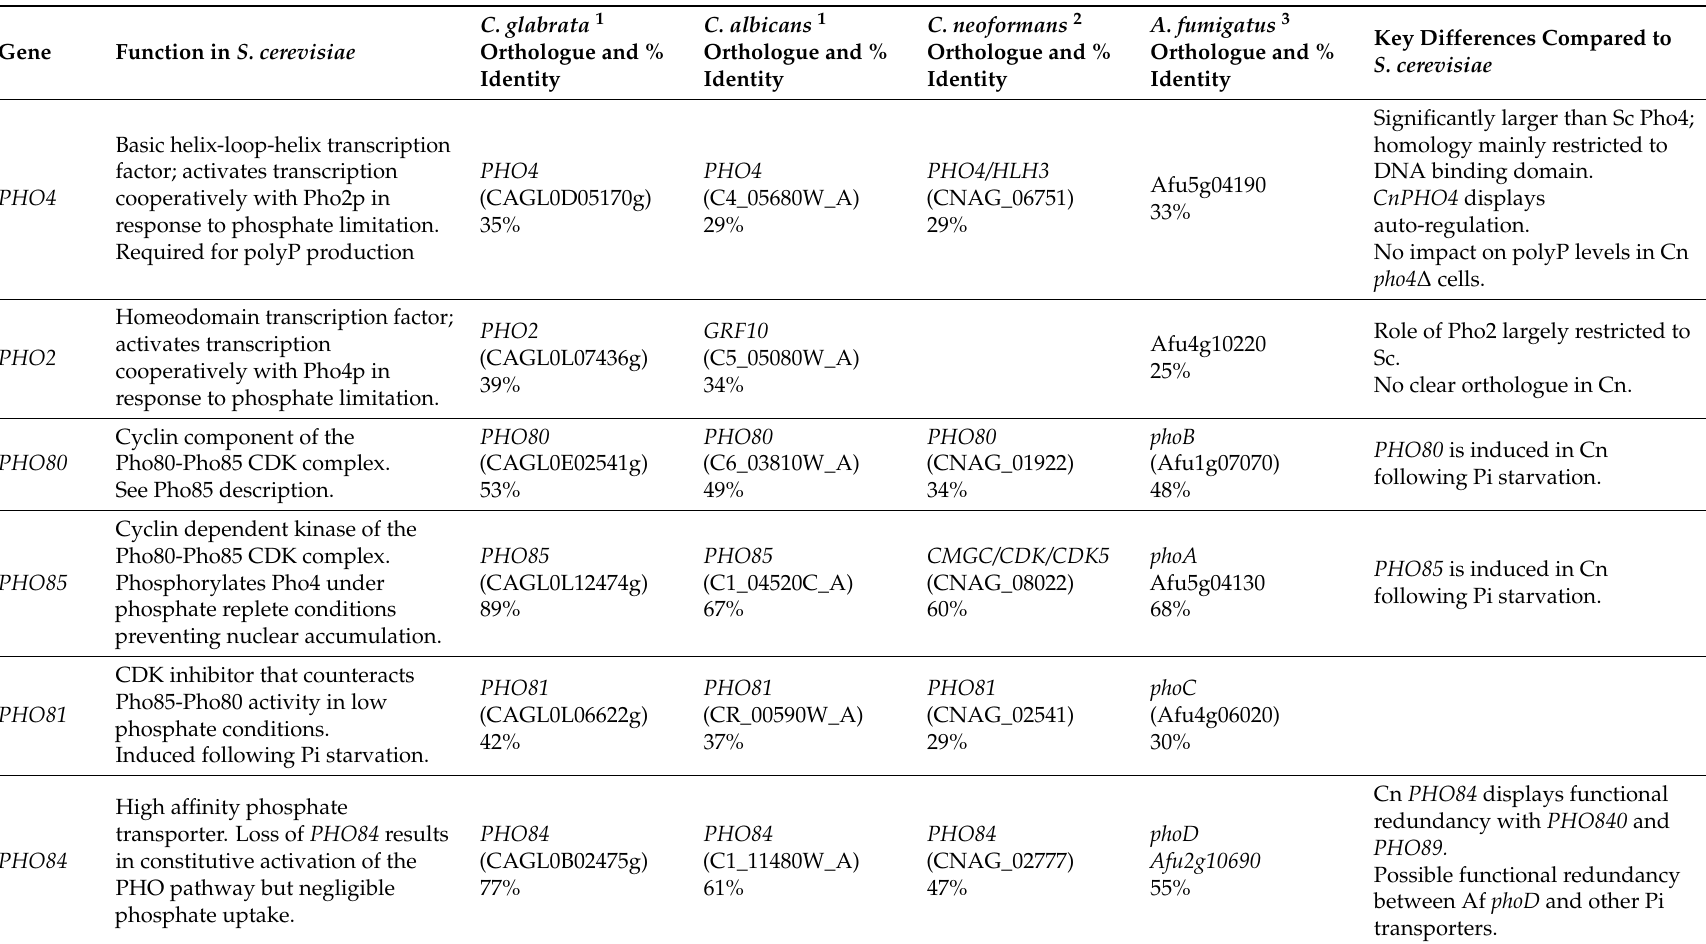
Table 1. Key Regulators of the S. cerevisiae PHO Regulon and their Orthologues in Human Fungal